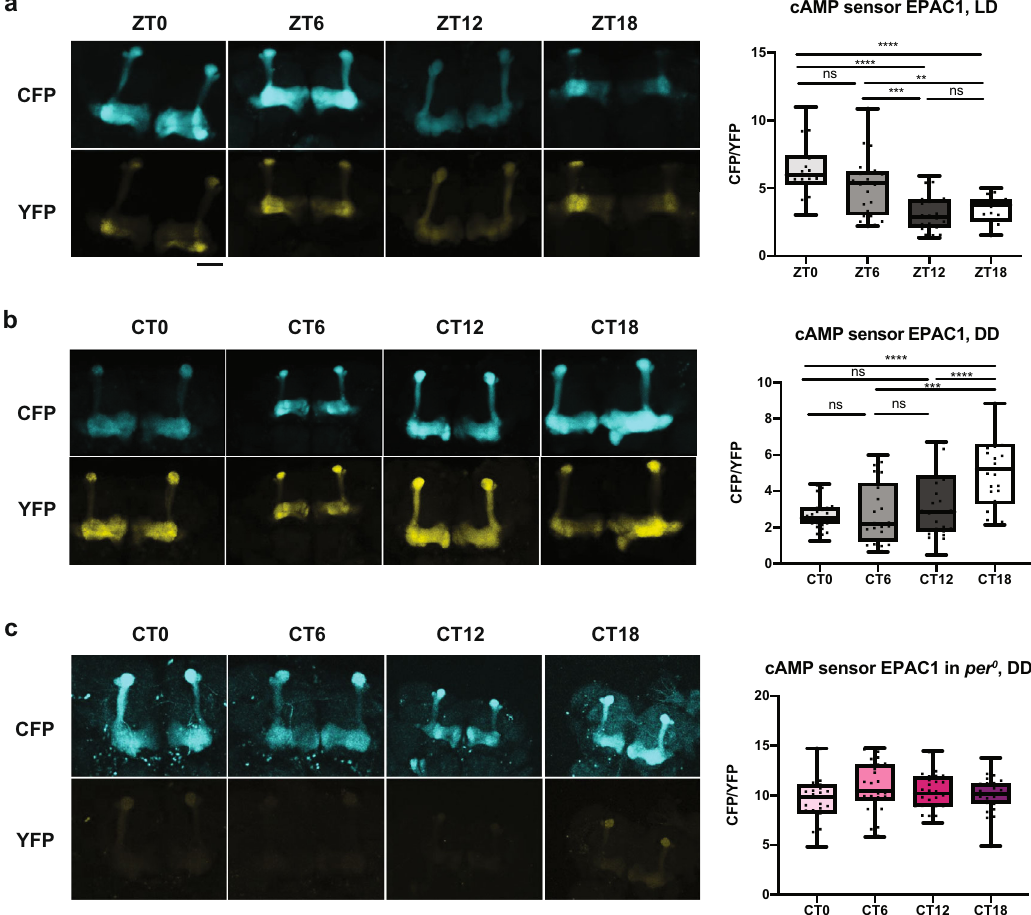
Fig. 7 Circadian control of cAMP levels in the MB. a – c Epac1-camp imaging of relative cAMP levels in MB neurons. Left, representative confocal images of the CFP and YFP emission. Scale bar, 25 μ m. Right, quanti fi cation of the CFP/YFP ratio. The center lines of the boxplots indicate the median and the whiskers represent the minimum and maximum values. Values between timepoints were compared using one-way ANOVA with Tukey ’ s multiple comparisons test (** p < 0.01, *** p < 0.001, and **** p < 0.0001). a Epac1-camp driven with 30Y-GAL4 in the w 1118 background. Images were acquired at four timepoints during LD. n = 20 – 30 brains per timepoint. b w 1118 in DD. n = 25 – 30 brains per timepoint. c per 0 in DD. n = 27 – 30 brains per timepoint. Source data are provided as a Source Data fi